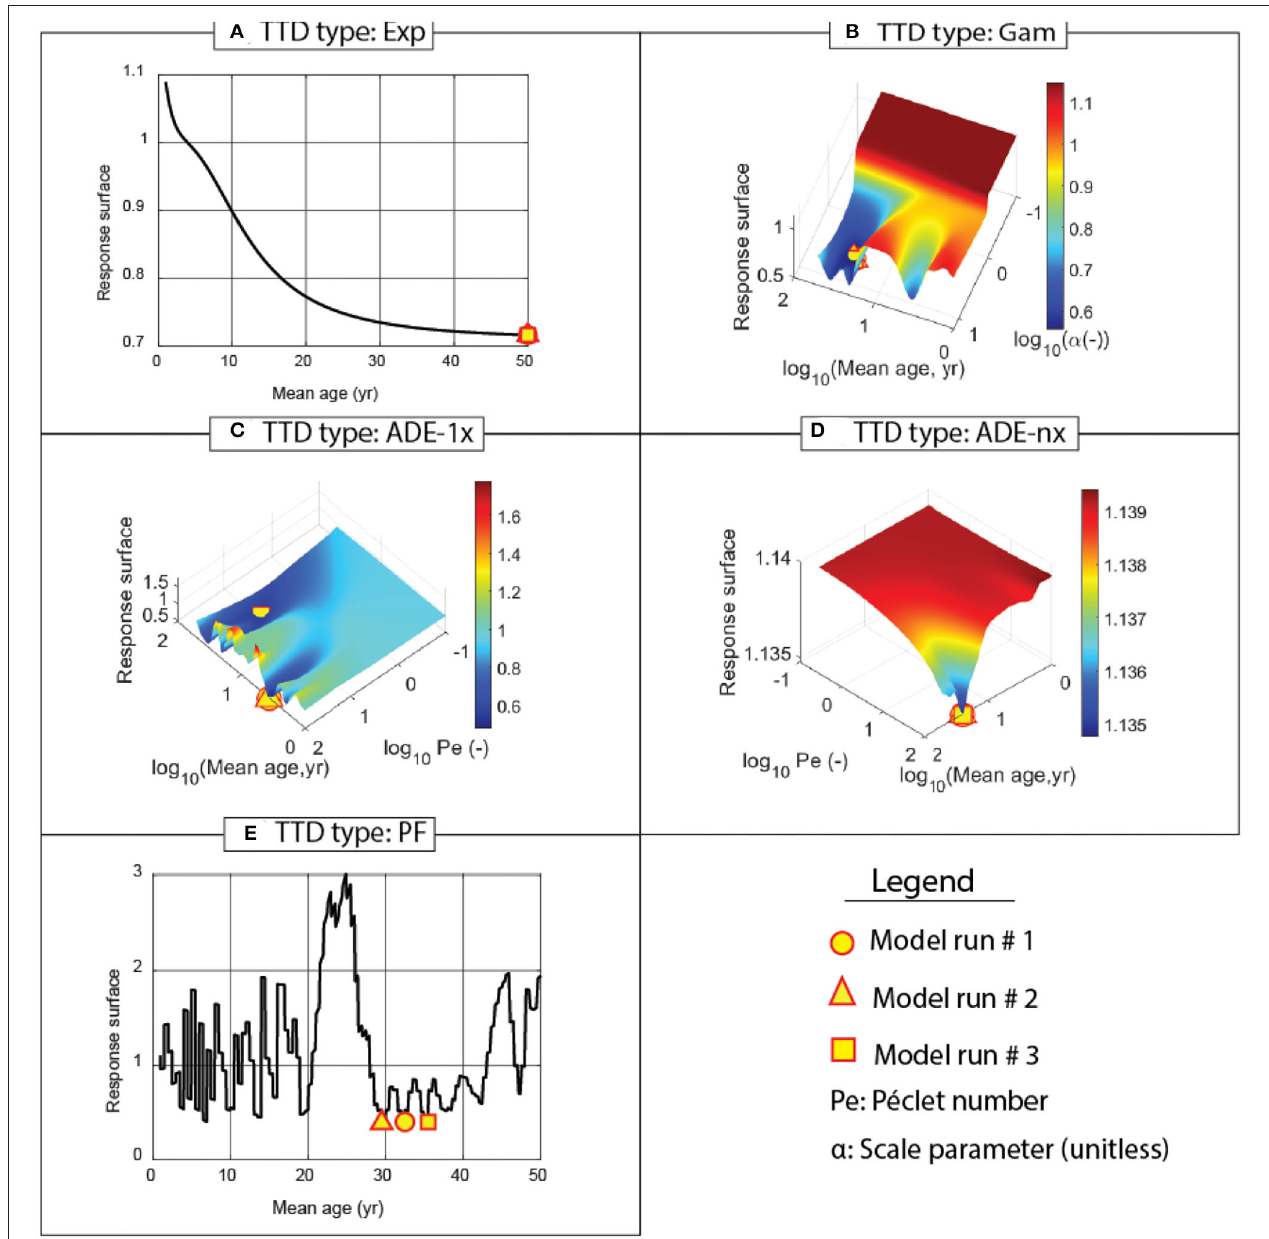
FIGURE 4 | Response surfaces—defined as the natural log of KGE’ as a function of TTD model parameters- for various TTD types using 3 H concentrations in precipitation and deep groundwater ( Figure 3 ). Results for the three separate model runs are shown as different symbols. Note that Supplementary Figure 3 through Supplementary Figure 7 in supporting information provide a zoomed-in view of the response surface for each TTD type as a separate figure. (A) TTD type: Exp, (B) TTD type: Gam, (C) TTD type: ADE-1x, (D) TTD type: ADE-1x, and (E) TTD type: PF.